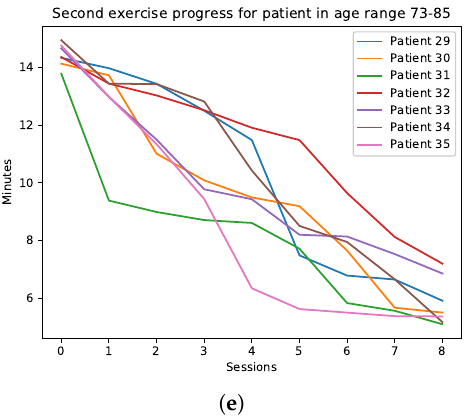
Figure 13. The performance of the patients for the third exercise. The plots are divided by age: ( a ) 25–36,